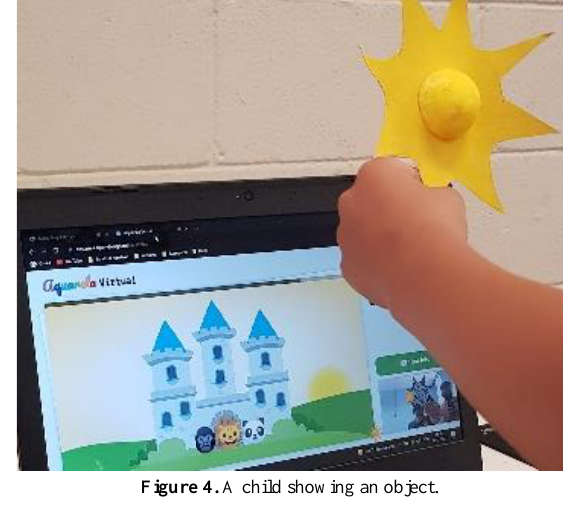
Figure 4. A child showing an object.